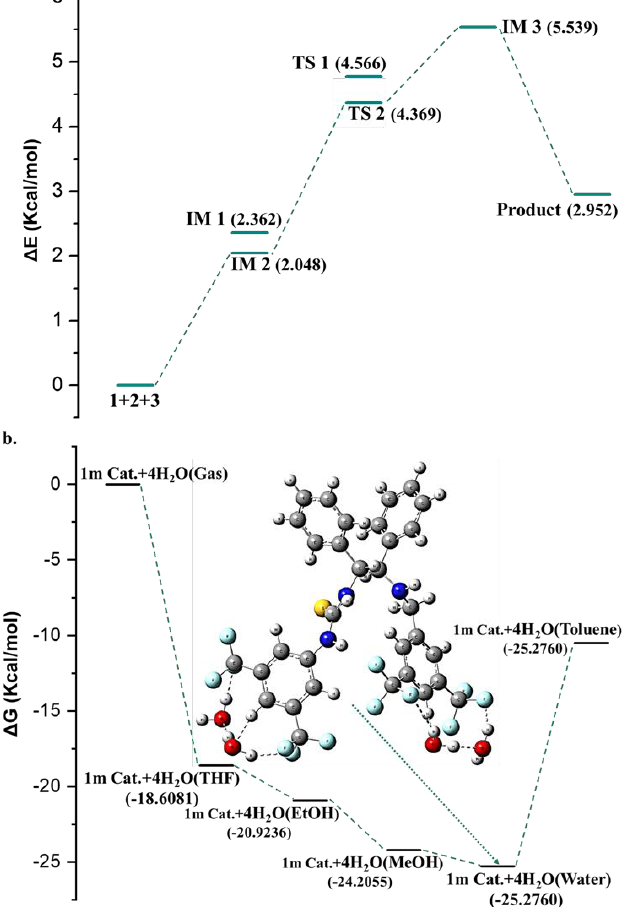
Figure 5. DFT−calculated energy diagram for the Michael reaction using β -nitrostyrenes. ( a ) ( R , R ) −1,2−diphenylethylenediamine (DPEN)−thiourea-catalyzed enantioselective Michael reaction calculated at the B3LYP/6−31G(d,p) level. Expected thermal energy of the Michael reaction. ( b ) Representation of a 1m catalyst at an aqueous binary mixtures calculated at the B3LYP/6−31G(d,p) level. 4−H substituted β −nitrostyrenes, the nitro group was reduced and cyclized to obtain the pyrrolidinone ring gave a β -phenyl− γ −amino−buta−noic−acid (GABA) derivative (prod-